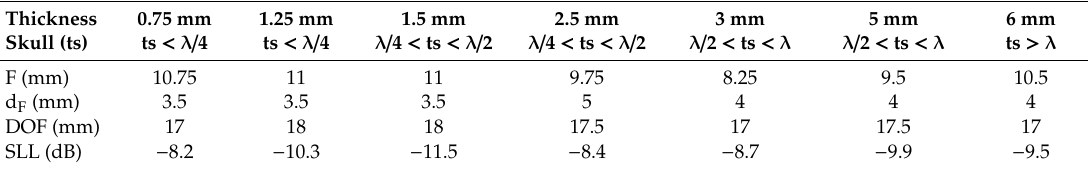
Table 3. Influence of the thickness skull in the focus of axicon lenses.